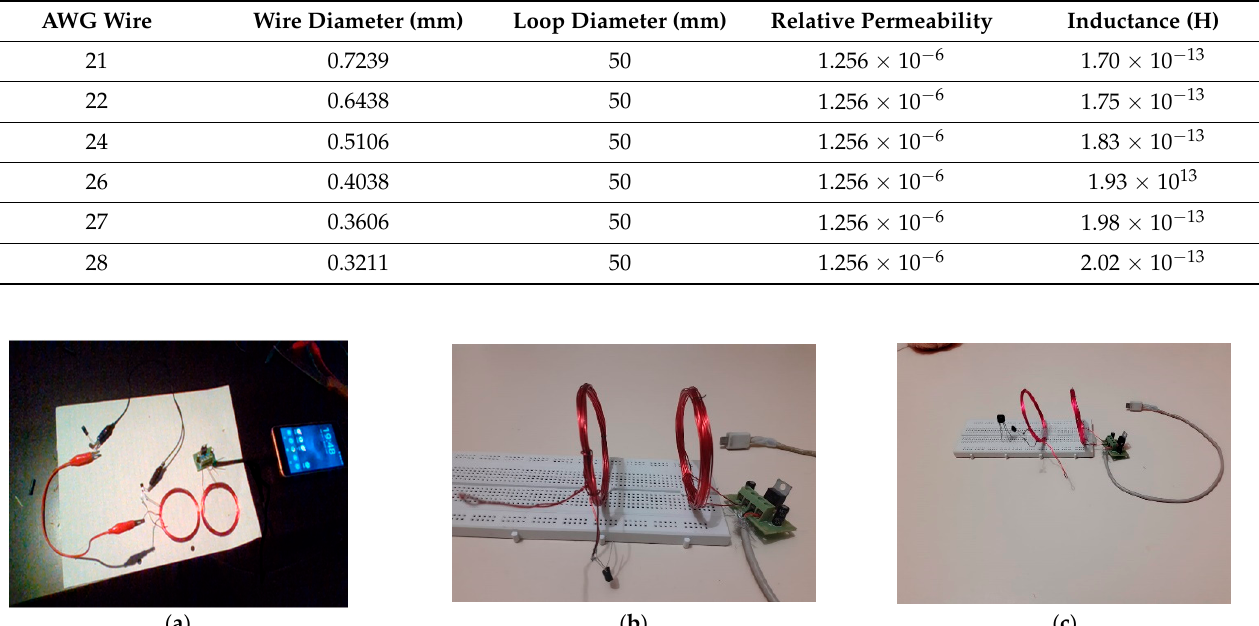
Table 2. AWG wire inductance comparison [39].